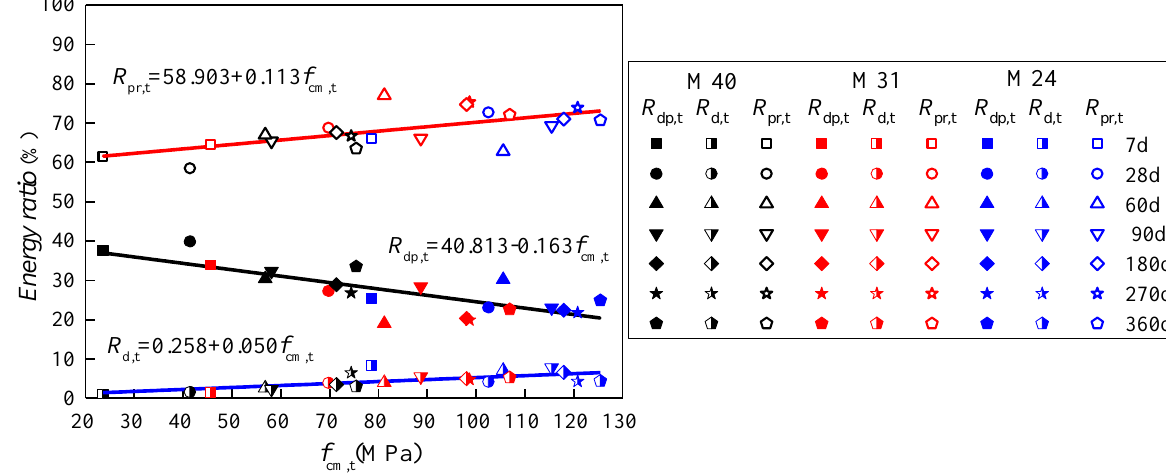
Figure 12. Relationship of the energy ratio and the compressive strength of mortar.